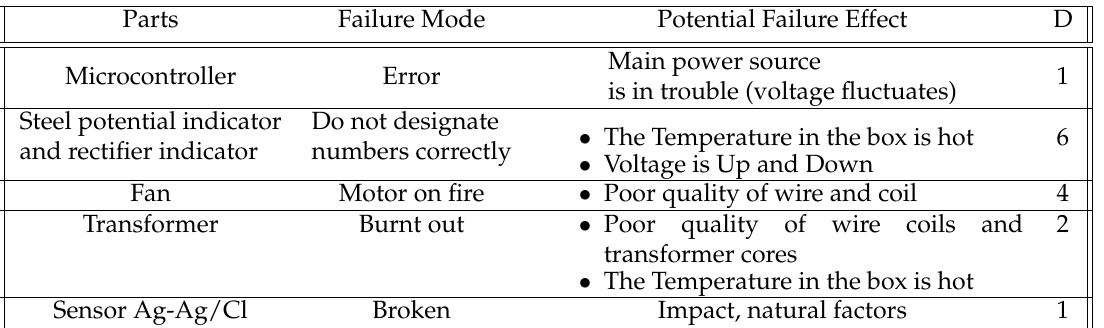
Table 4. Result of Detection scores for Failure in